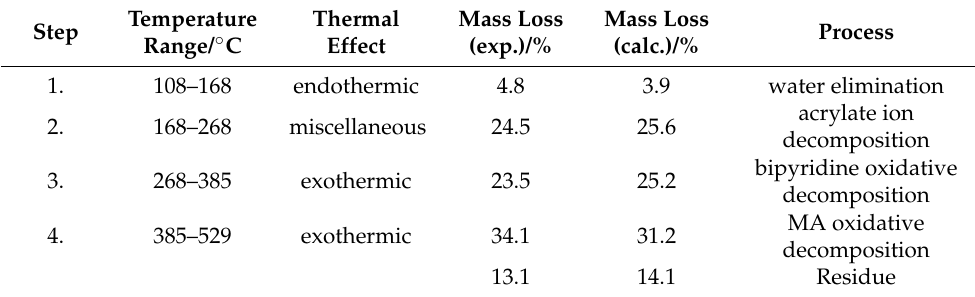
Table 2. Thermal decomposition data (in air flow) for co-crystal.